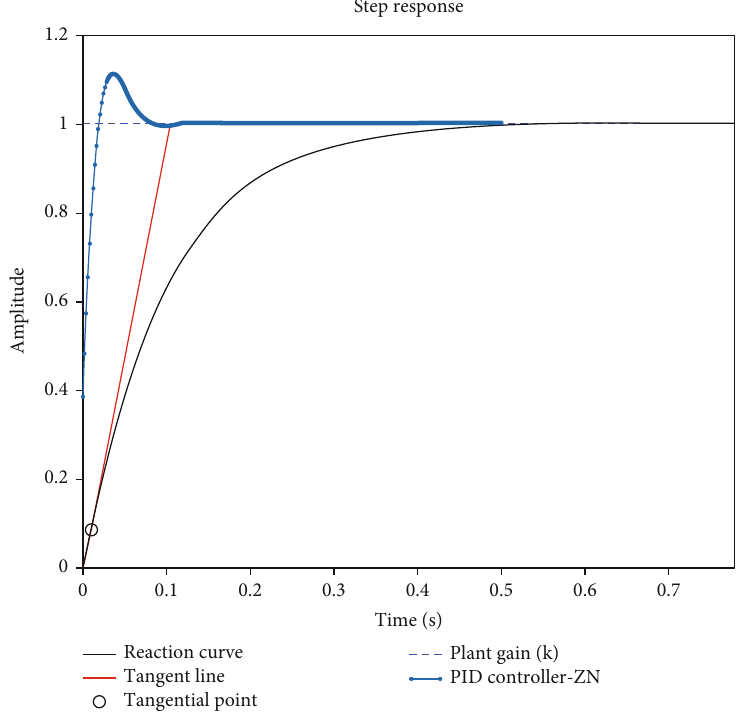
Figure 7: Reaction curve or a